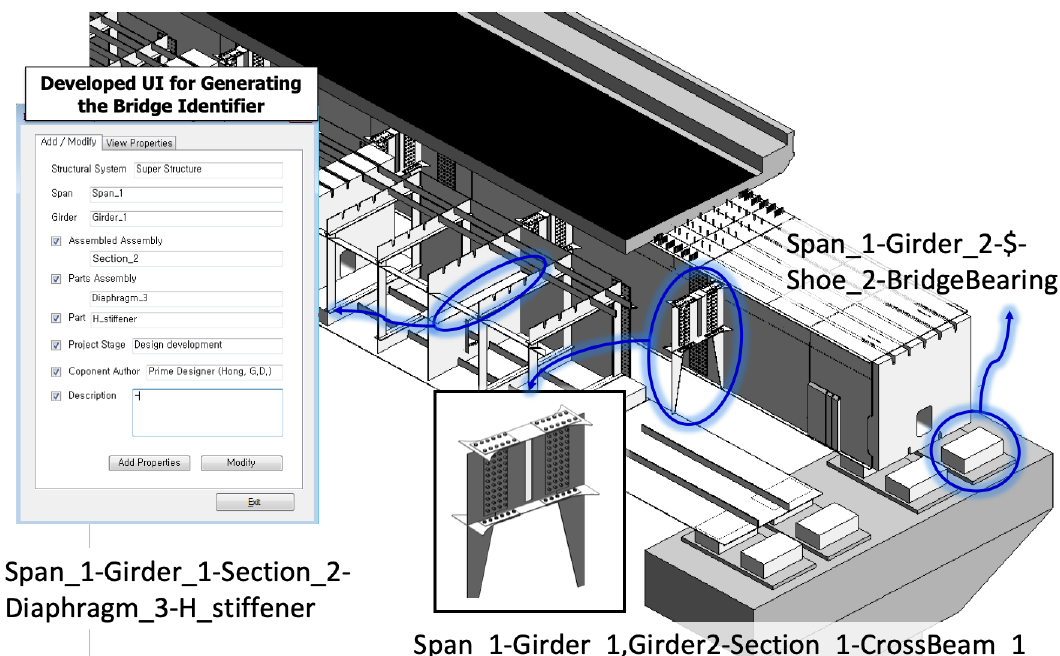
Figure 11. Drawings of a sample steel box girder bridge.